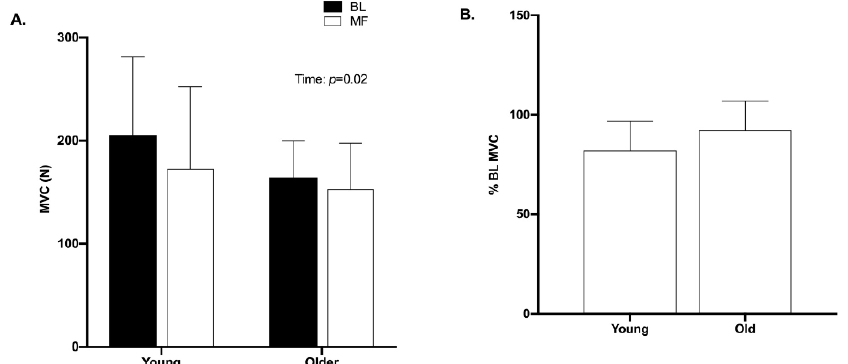
Table 1. Participant characteristics.